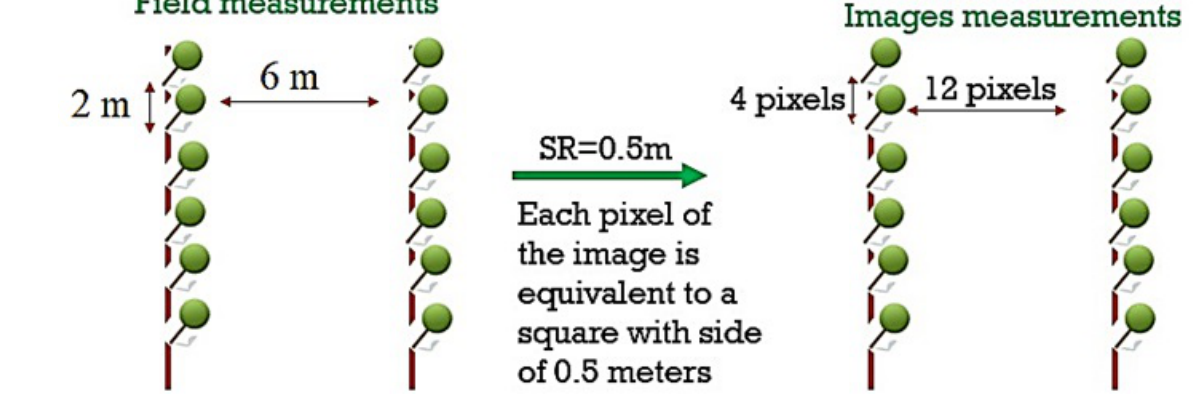
Figure 6. Trees distribution in the field.